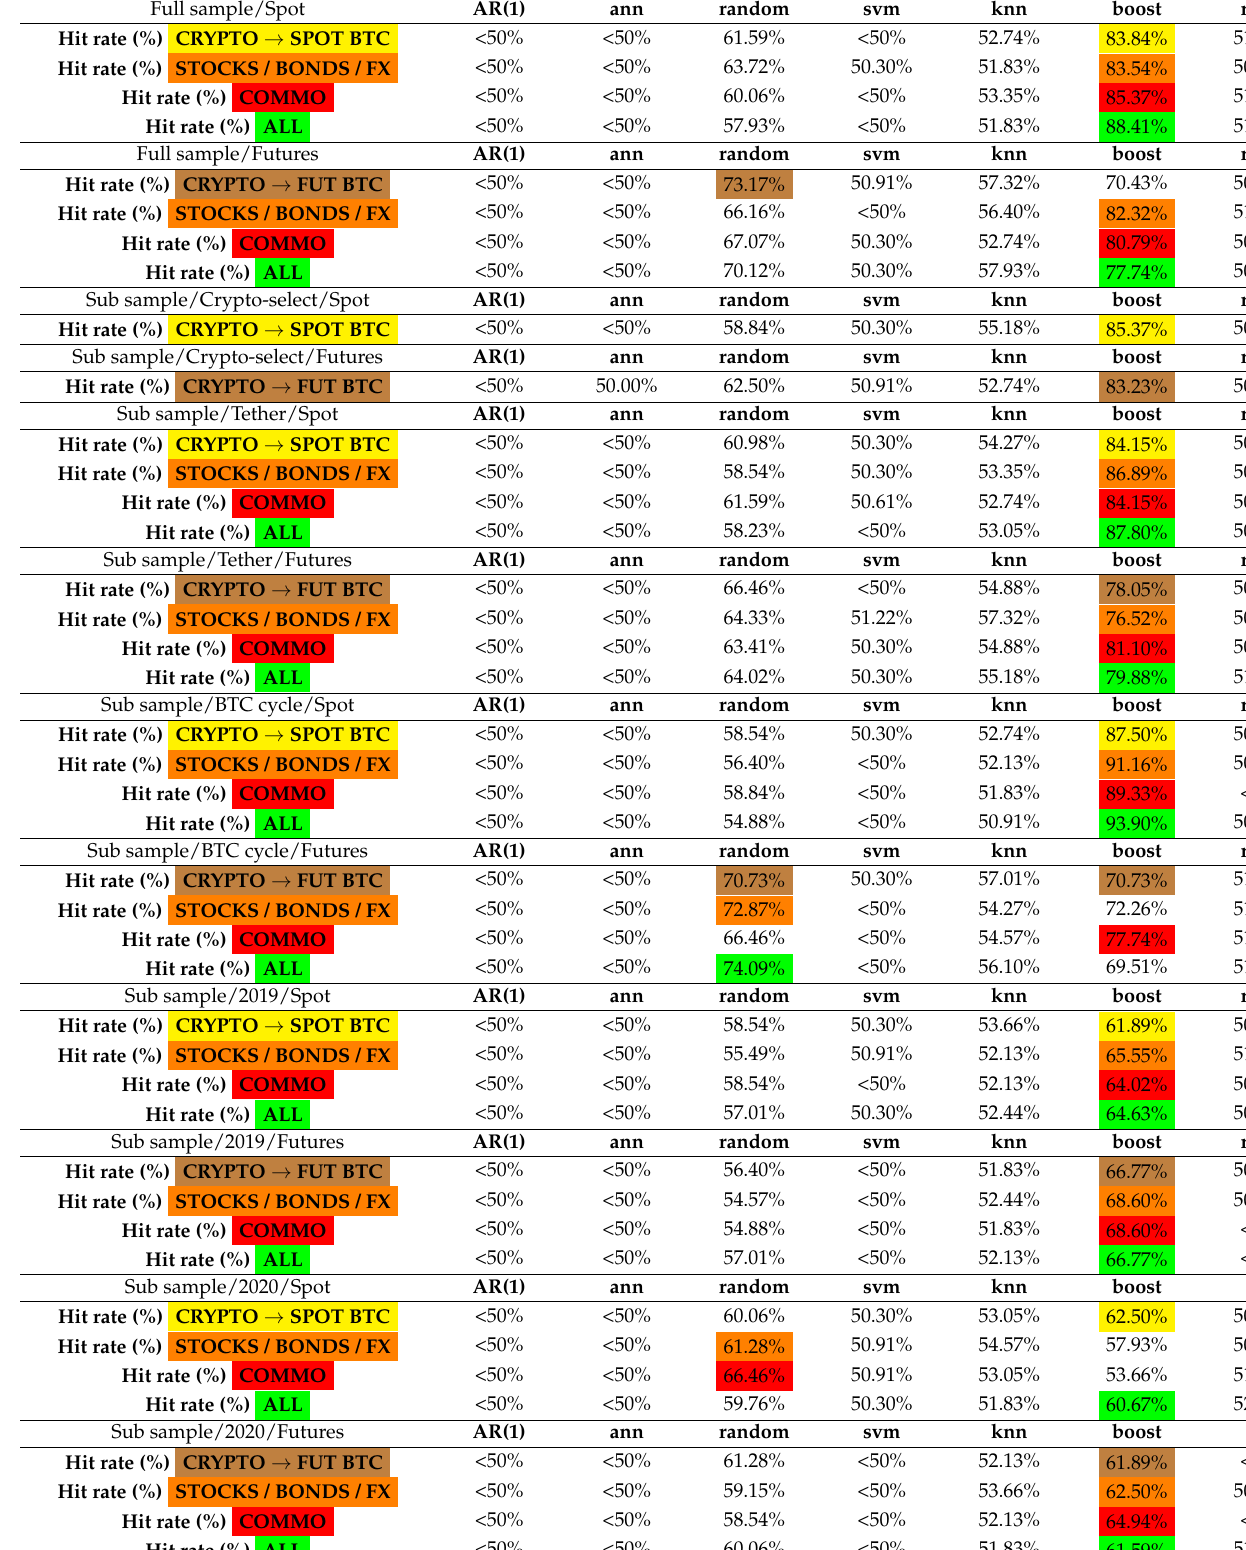
Table 14. Hit rate performance